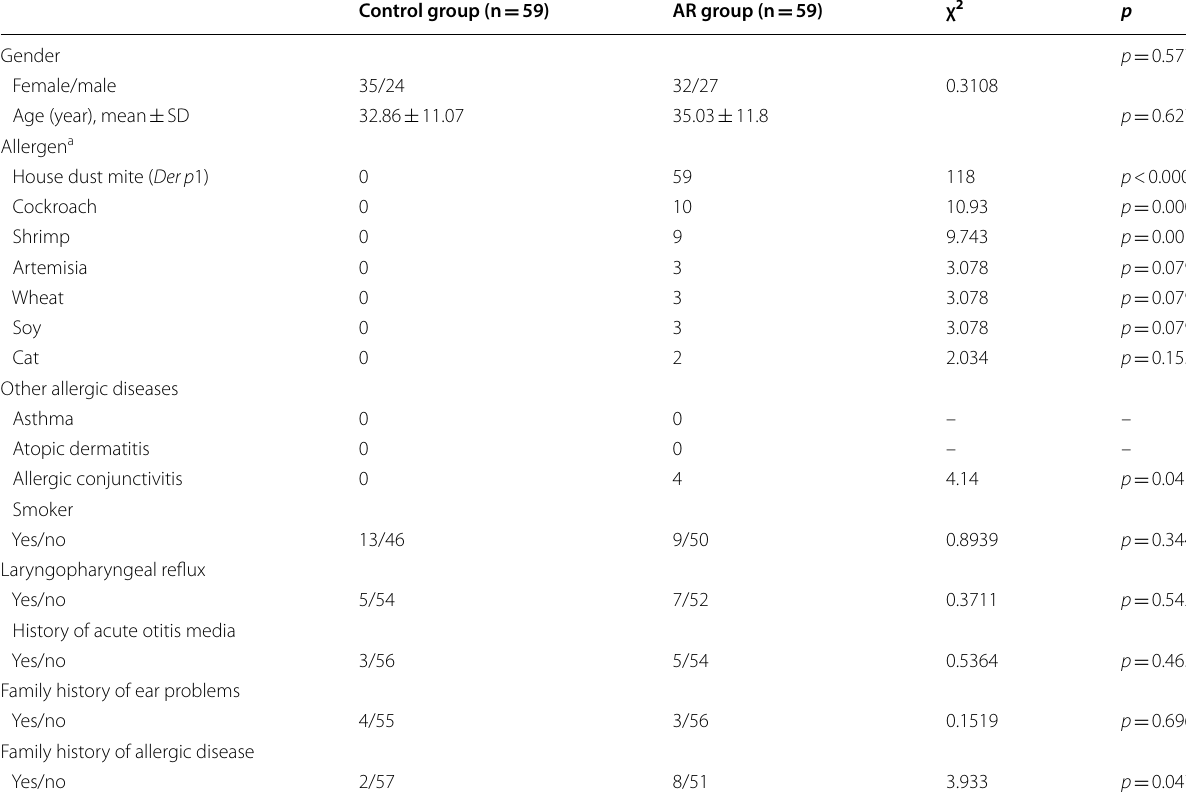
Table 2 Clinical characteristics for Control group and AR group